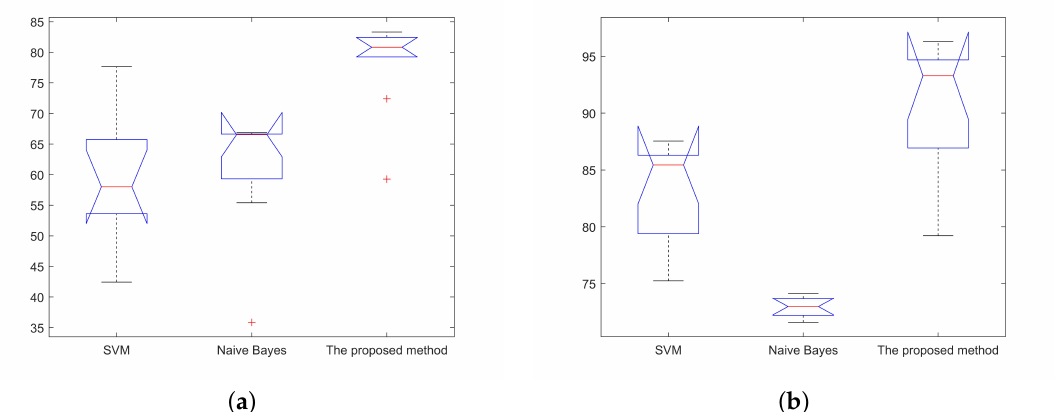
Figure 10. Statistical significance test of F1-scores for different models. ( a ) English dataset (F-statistics is 12.34). ( b ) Chinese dataset (F-statistics is 48.05).